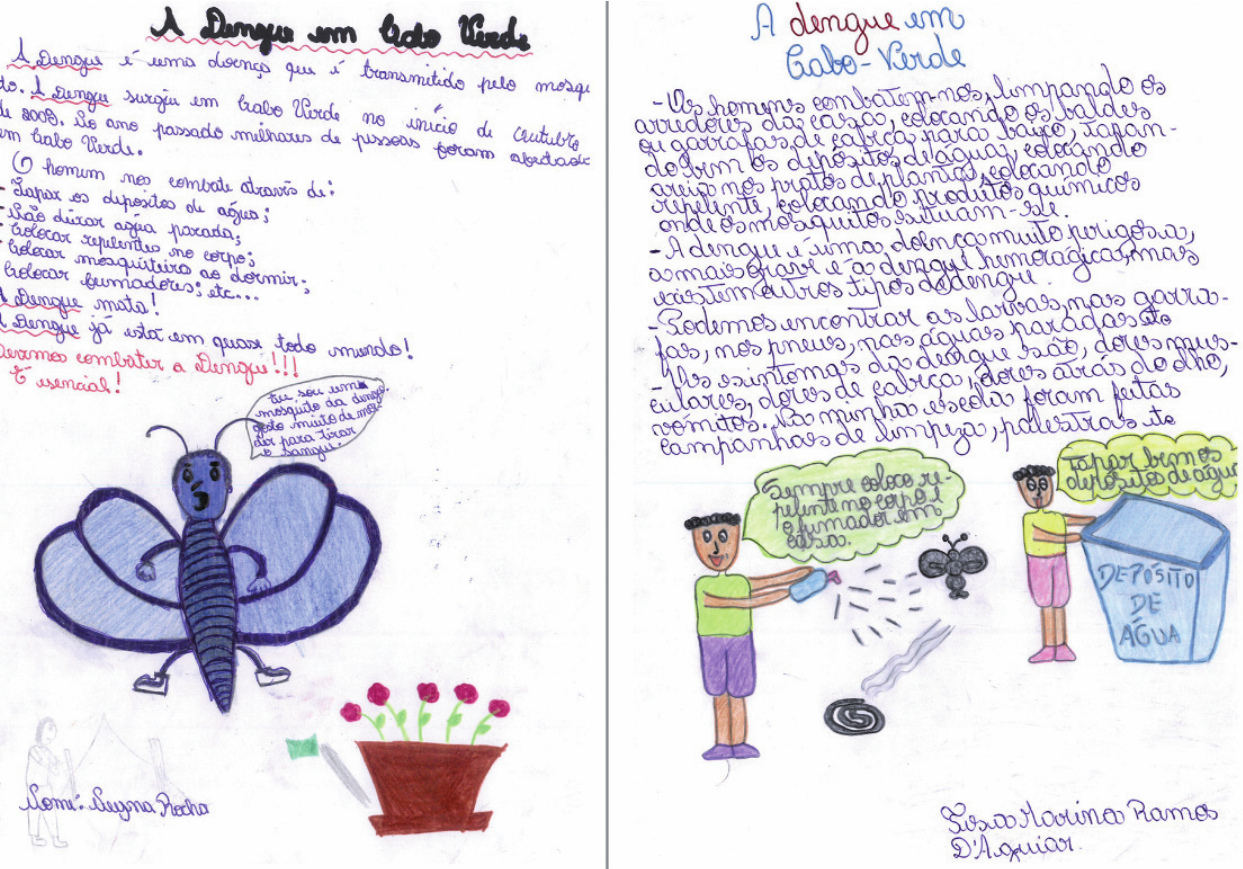
Figure 2. Reports of students of primary school in Praia to explain to their Italian partners the best practices to prevent the diffusion of the epidemic spread of the disease. In these drawings, the two students suggest collection of the waste, cleaning of the roads, avoiding leaving water in containers like bottles or cans, not leaving water in plant vases, covering water tanks, avoiding leaving waste around, using repellents, and using mosquito nets during the